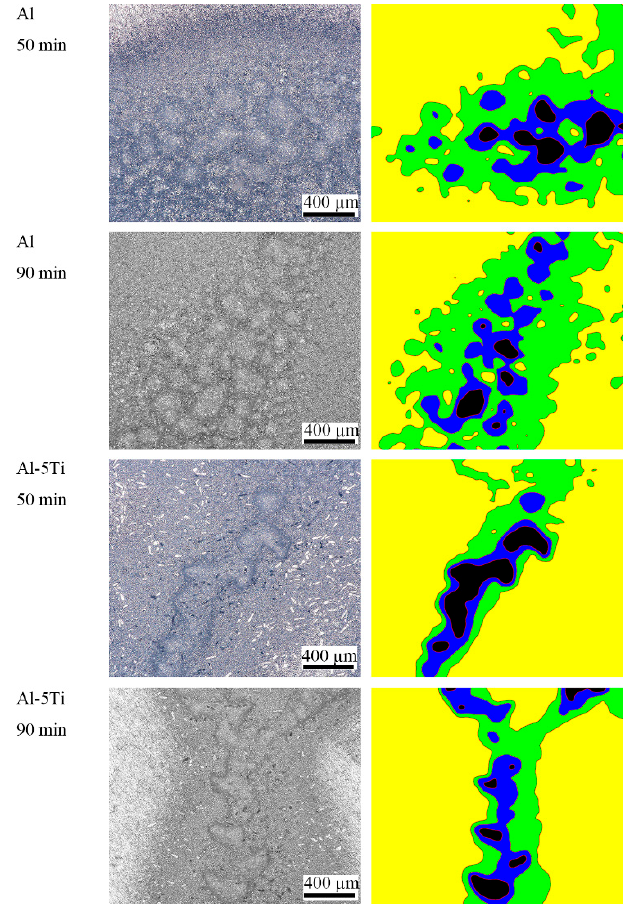
Figure 4. The OM photos of Al and Al-5Ti alloys after cavitation erosion for 50 min and 90 min, and its corresponding surface profile on the right.